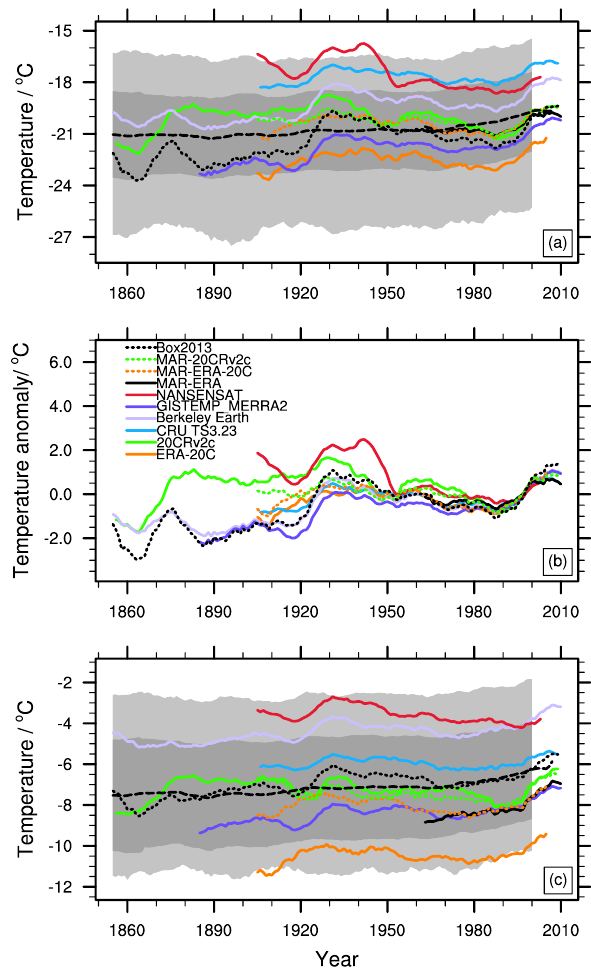
Figure 6. (a) Time series of ice sheet areal average smoothed annual mean SAT for long reanalyses, gridded temperature analyses and all three MAR variants (elevation corrected where applicable; colored lines) and CMIP5 climate models (not elevation corrected; ensem- ble mean in dashed black line; ± 1 standard deviation in dark grey shading; maxima and minima in light grey shading). (b) Anoma- lies of ice sheet areal average smoothed annual mean SAT from long reanalyses, gridded temperature analyses and both MAR vari- ants, relative to 1981–2010 mean. (c) As in (a) but for June–August mean SAT. In all panels, time series are smoothed using a centered, uniform-weighted 11-year window, to highlight decadal variability and aid